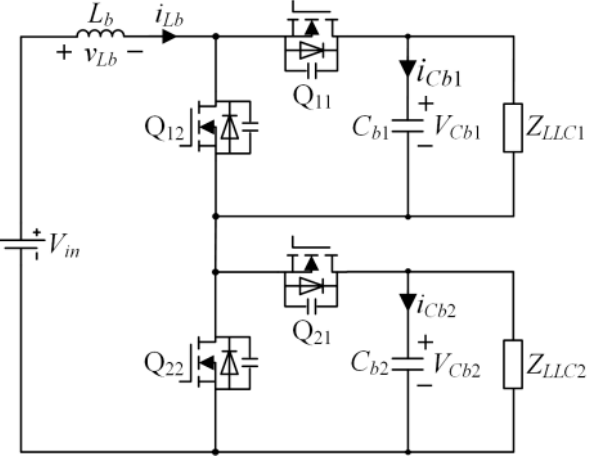
verters, respectively. As the Boost inductors of the two converters are in series, they are regarded as the equivalent inductor L b in the analysis, while v Lb and i Lb are the voltage and current of the equivalent inductor L b , respectively. Z LLC 1 and Z LLC 2 are the input impedances of two full-bridge LLC resonant converters.